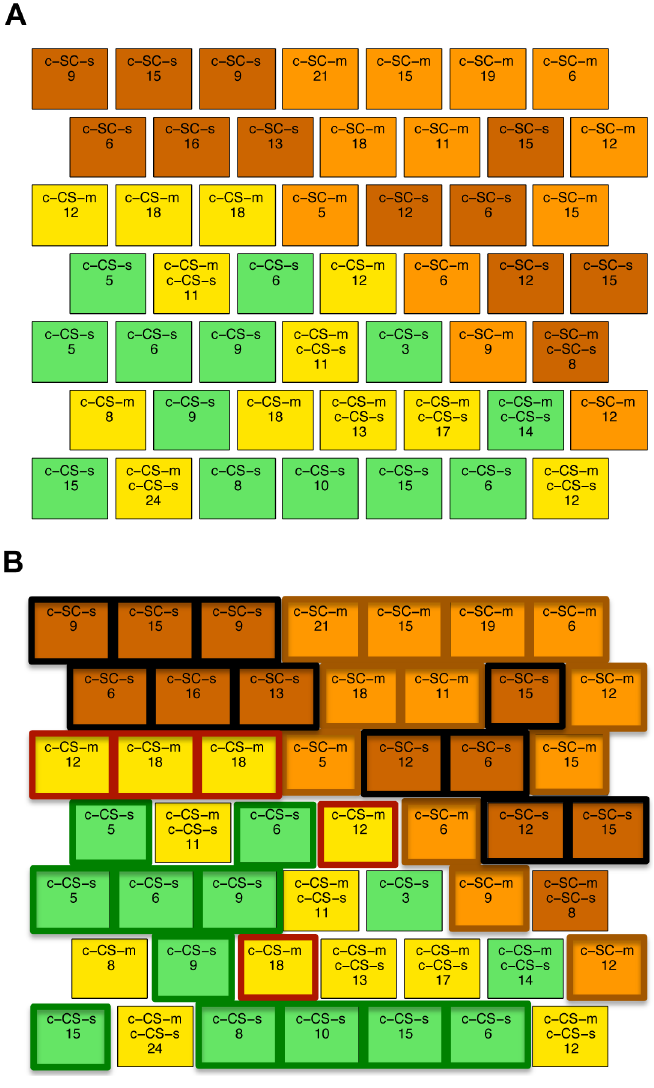
Fig 2. (A) SOM clustering of four classes of control mice. Node color indicates the majority class of the measurements clustered within it: brown: c-SC-s; orange: c-SC-m; green: c-CS-s, yelow: c-CS-m. Nodes are labeled with the name(s) of the majority and minority class(es) and the total number of measurements contained within them is also shown. (B) Strong class-specific clusters are outlined as black: c-SC-s; brown: c-SC-m; green: c-CS-s; dark red: